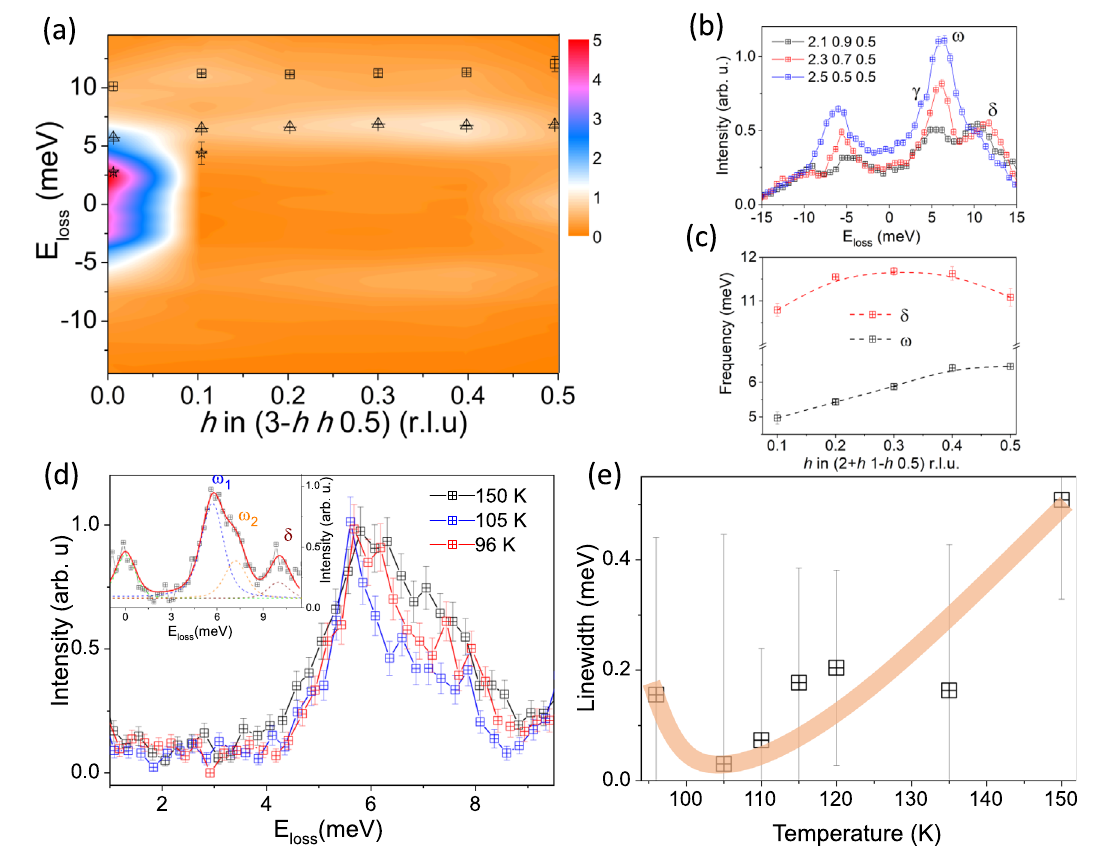
Fig. 4 | Einstein modes and phonon broadening. a Color map of the low-energy phonons of CsV 3 Sb 5 along the (3- h h 0.5) direction at 120 K. The three modes identi fi ed at 2.5 ( γ , asterisks), 6 ( ω , triangles) and 11 meV ( δ , squares) are superimposed. b IXS spectra and c dispersion along the (2+ h 1 - h 0.5) direction ( Δ E=3meV) of the δ and ω branches. d Temperature dependent high resolution